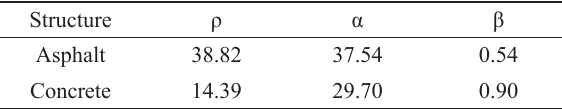
Table 2. Parameters of performance models considered in the analysis